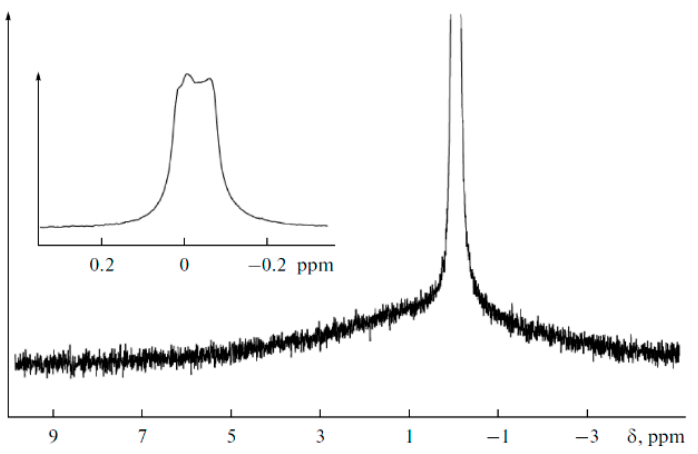
Figure 29. The narrow line is a lithium perchlorate signal, while wide pedestals are due to lithium from nanoparticles. The narrow line consists of two lines attributed to different lithium positions (insert in Figure 29). The narrow line without splitting is observed for the polymer electrolyte with TiO 2 addition.